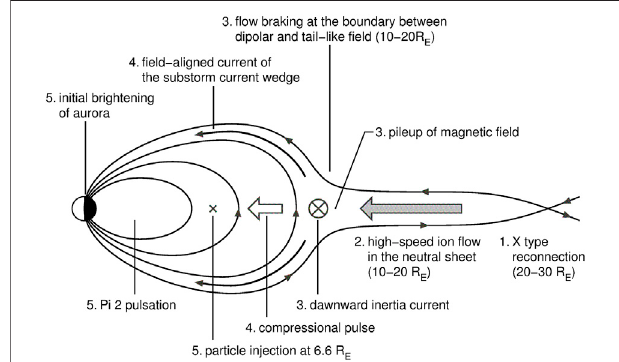
FIGURE 2 | Model proposed by Shiokawa et al. (1998a) for the current wedgeformationduringtheinitialstageofthesubstormexpansionphase.The number preceding each comment indicates the order of occurrence. The braking point of the Earthward fl ow moves tailward due to the pileup of magnetic fi eld carried by the fl ow. This motion probably corresponds to the poleward expansion of aurora. The transition from tail-like fi eld to dipolar fi eld at the braking point is due to the downward inertia current. The substorm current wedge is formed at the braking point by the inertia current and the current due to fl ow shear. The fl uctuation of fi eld-aligned currents and the compressional pulses generated at the braking point can be the cause of the Pi2 pulsation in the inner